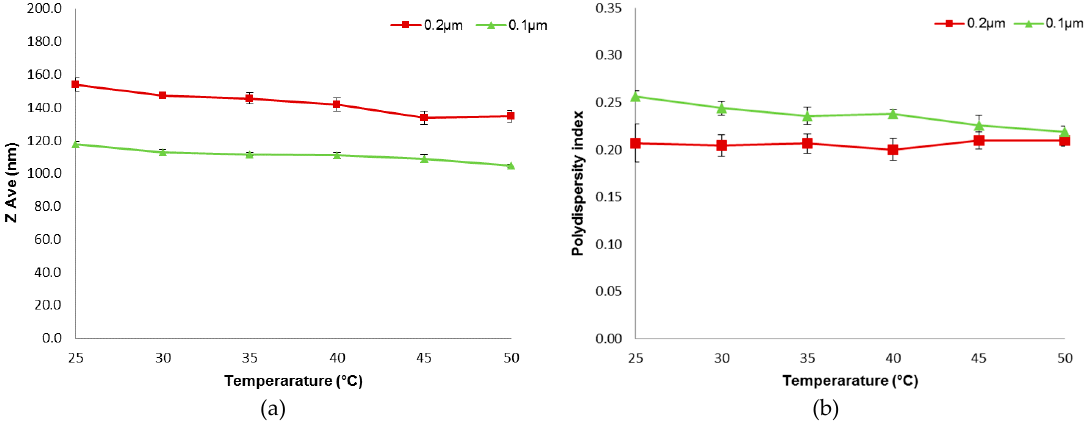
Figure 5. Influence of temperature on the ( a ) particle size and ( b ) polydispersity index of the extruded liposomes (Mean ± SEM, n = 6).